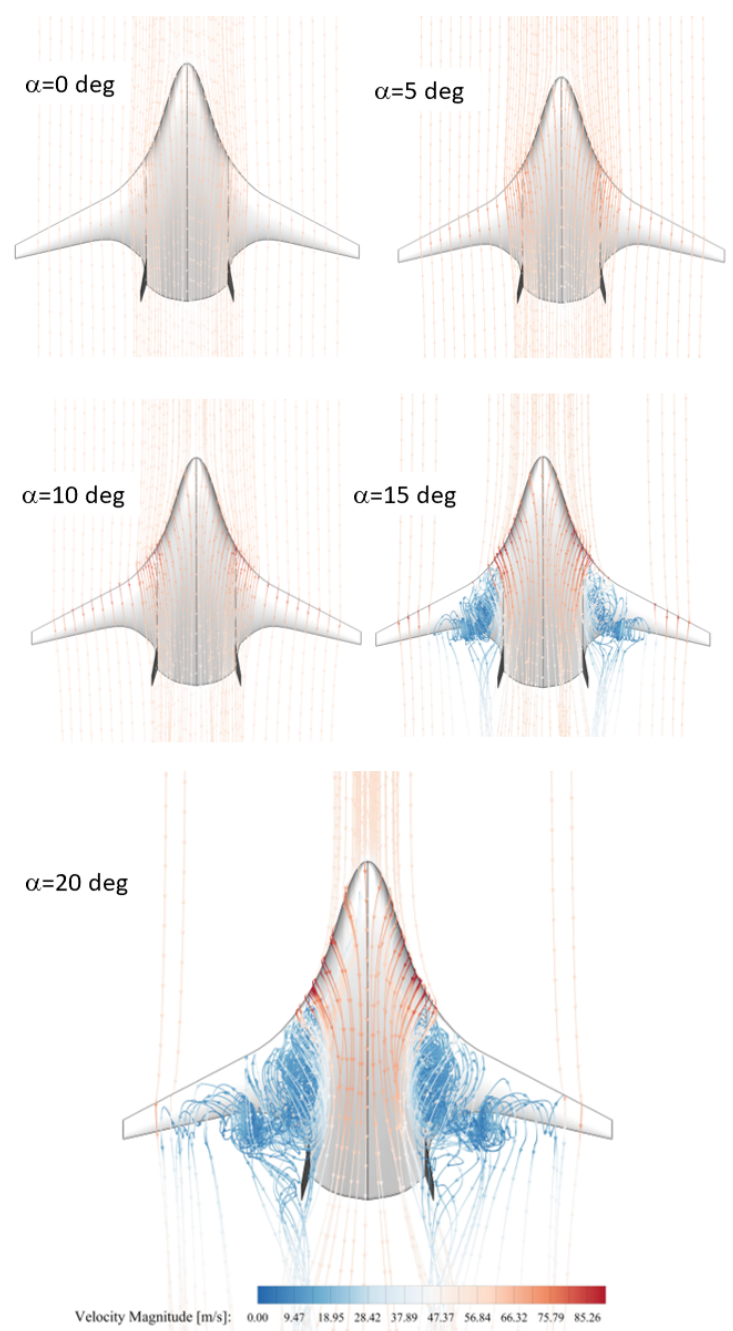
Figure 9. Computed streamlines at α = 0 ◦ , 5 ◦ , 10 ◦ , 15 ◦ , 20 ◦ ; colour scale based on velocity